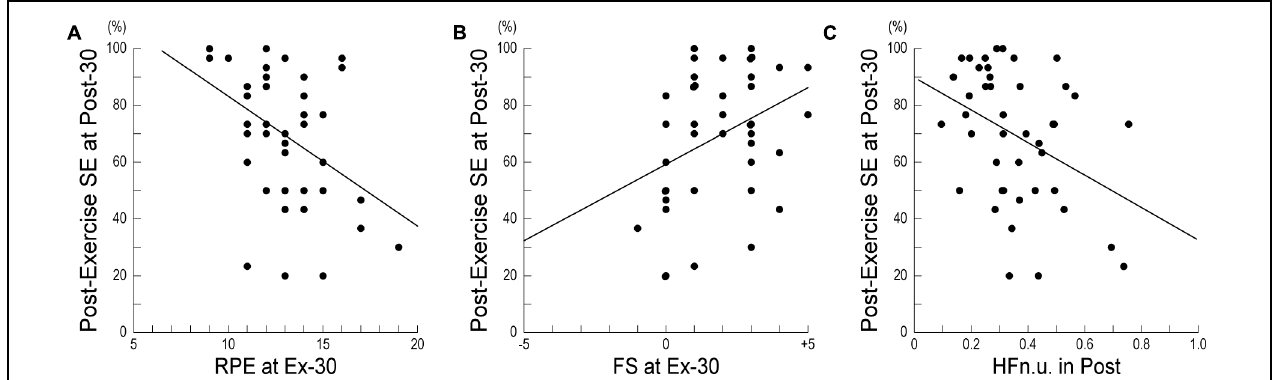
FIGURE 2 | Relationship between post-exercise self-efficacy and subjective or physiological measures. (A) Relationship between post-exercise SE and RPE at Ex-30 ( r = 0.167, p < 0.05). (B) Relationship between post-exercise SE and FS at Ex-30 ( r = 0.125, p < 0.05). (C) Relationship between post-exercise SE and HF n . u . in Post ( r = 0.145, p < 0.05). SE, Self-Efficacy; RPE, Rating of Perceived Exertion; FS, Feeling Scale; HF n . u . , high-frequency power of heart-rate variability in normalized